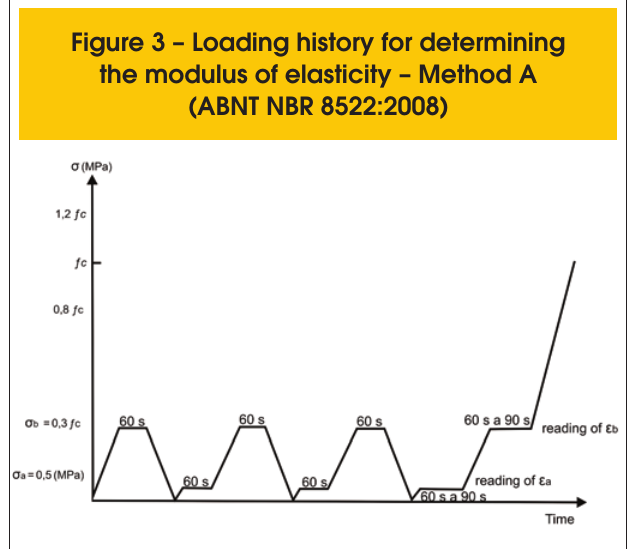
Figure 3 – Loading history for